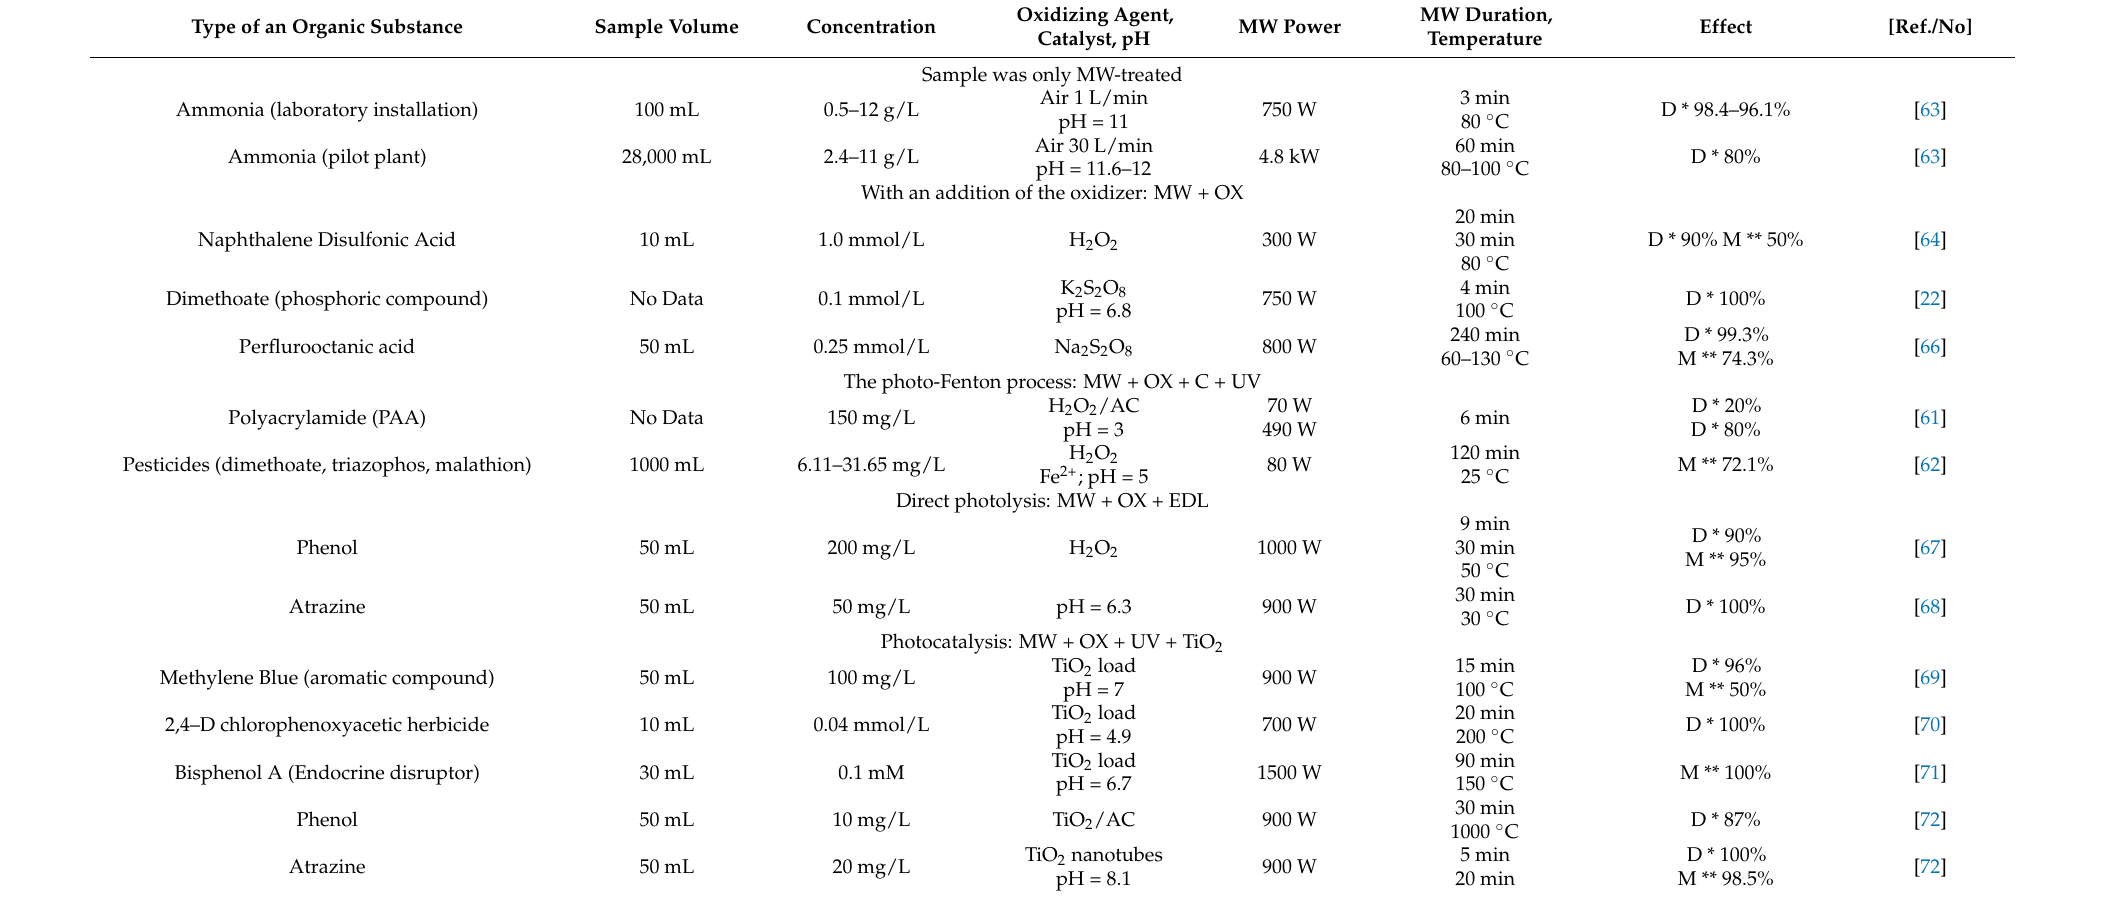
Table 6. The efficiency of MW oxidation of organic substances in